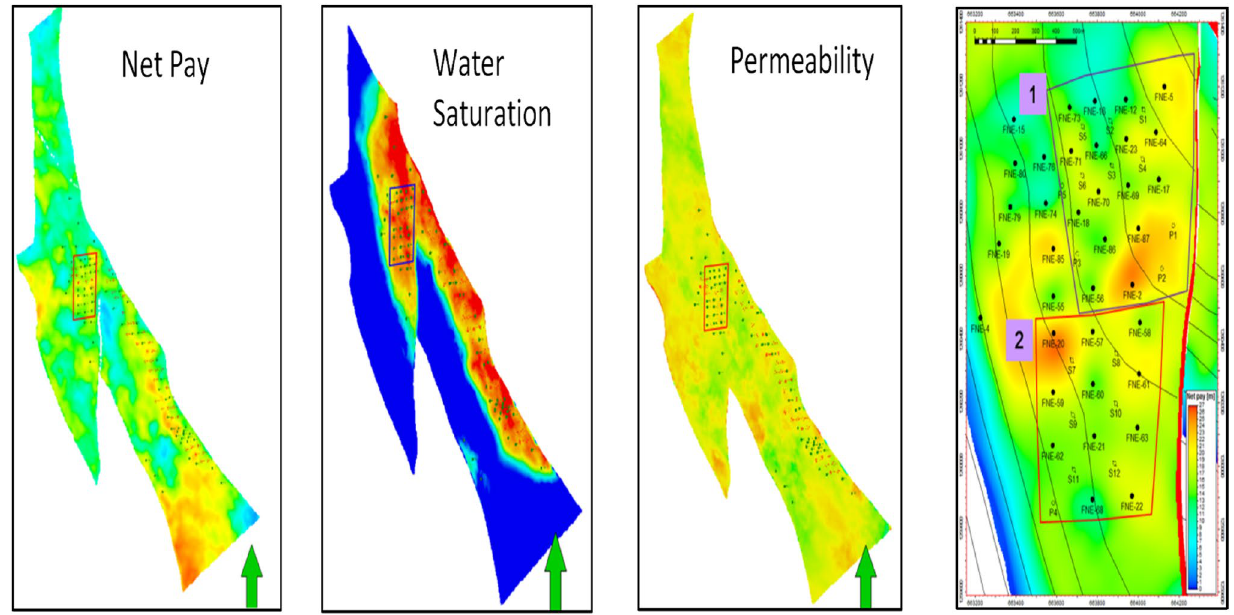
Fig. 3 Reservoir properties and pilot